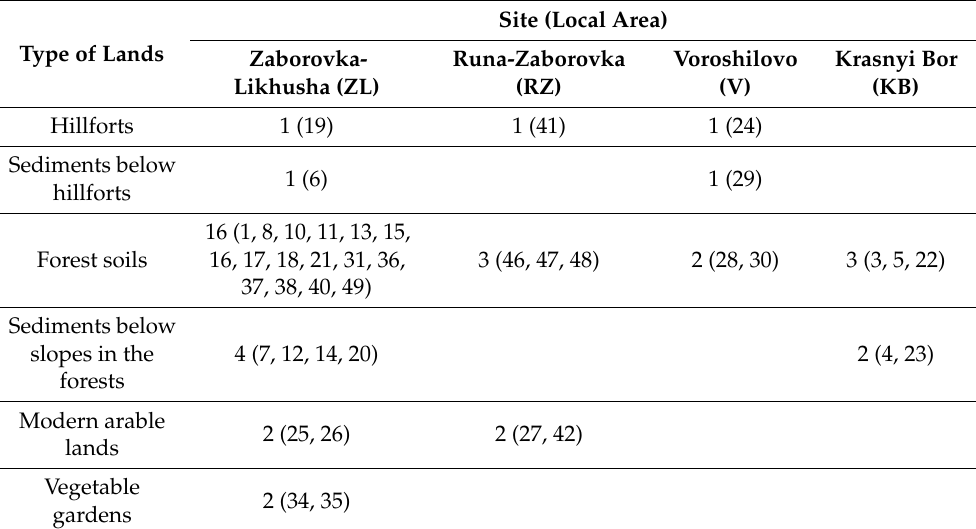
Table 1. Land types in the studied sites with the amount of soil profiles (individual profile numbers are given in